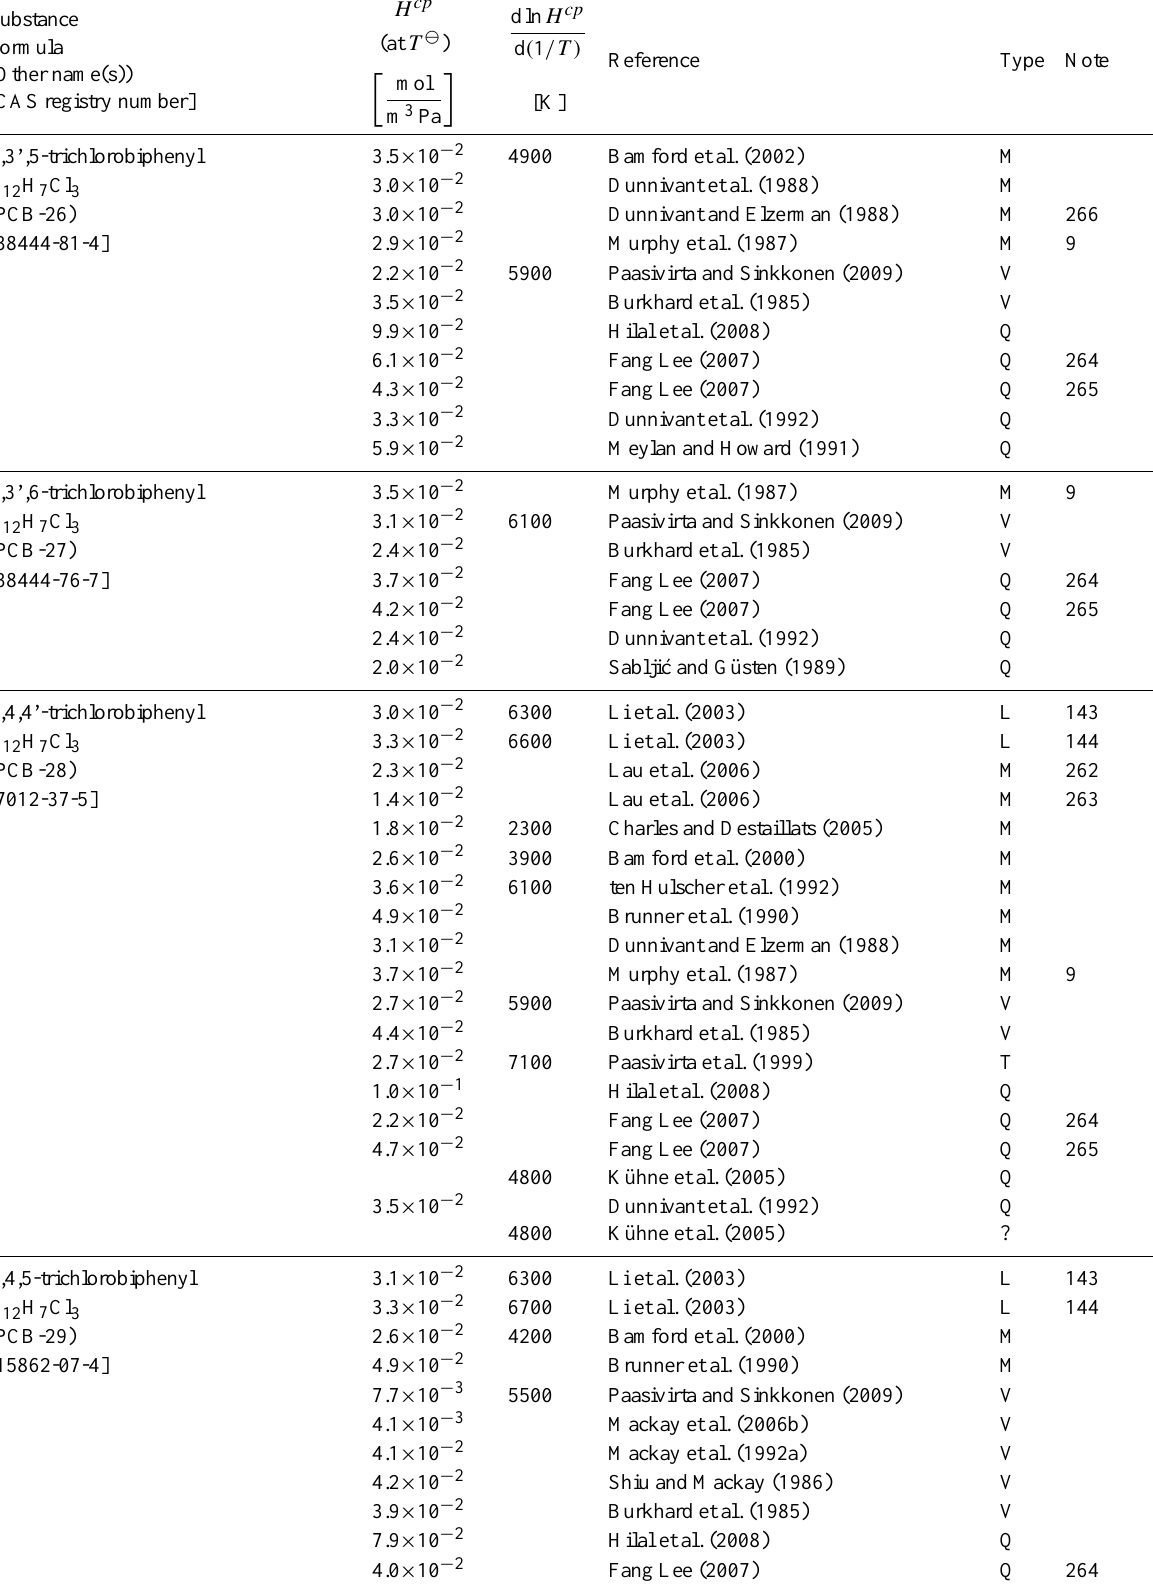
Table 6: Henry’s law constants for water as solvent